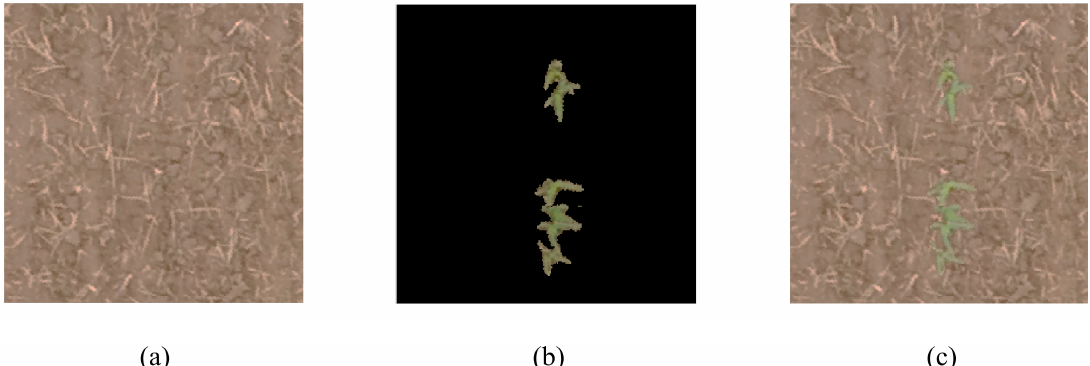
Figure 4. Steps of training image patch generation: ( a ) A sample generated background image; ( b ) extracted and implanted single plants with normal shapes; ( c ) final generated training patch with a combination of the generated background and single plant images.